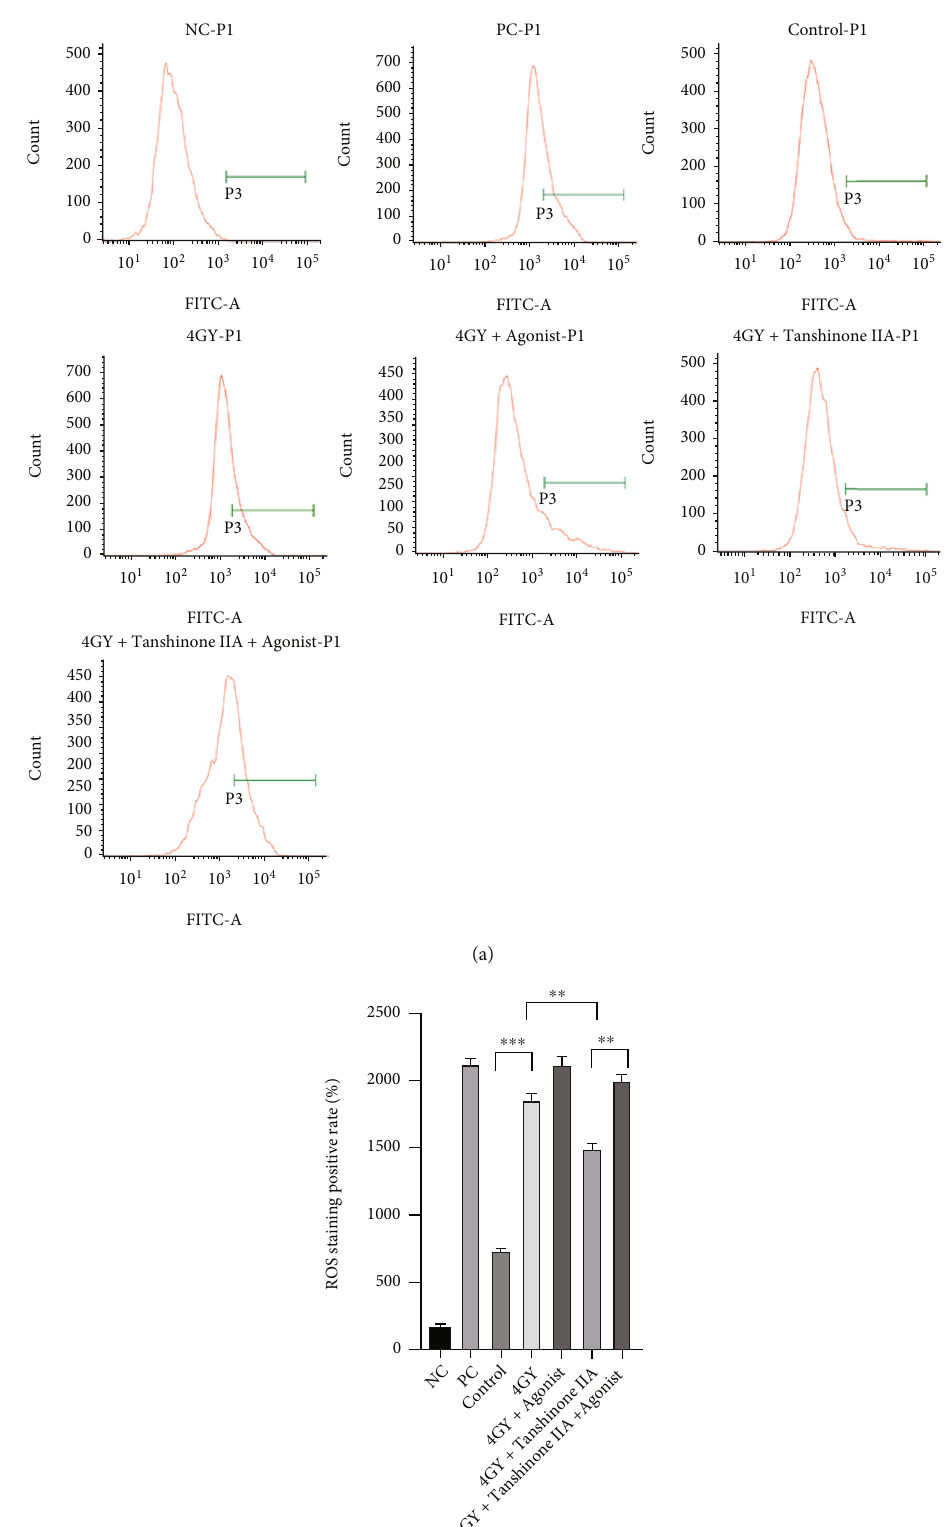
Figure 3: E ff ects of radiation and tanshinone IIA on oxidative stress in cardiomyocytes. (a) The ROS pro fi le of each grouped cell was determined by fl ow cytometry. (b) The positive rates for ROS staining are expressed as mean ± SD . All results are presented as means ± SD ( n = 3 ). ∗∗∗ P < 0 : 001 and ∗∗ P < 0 : 01 . ROS: reactive oxygen species; NC: negative control; PC: positive